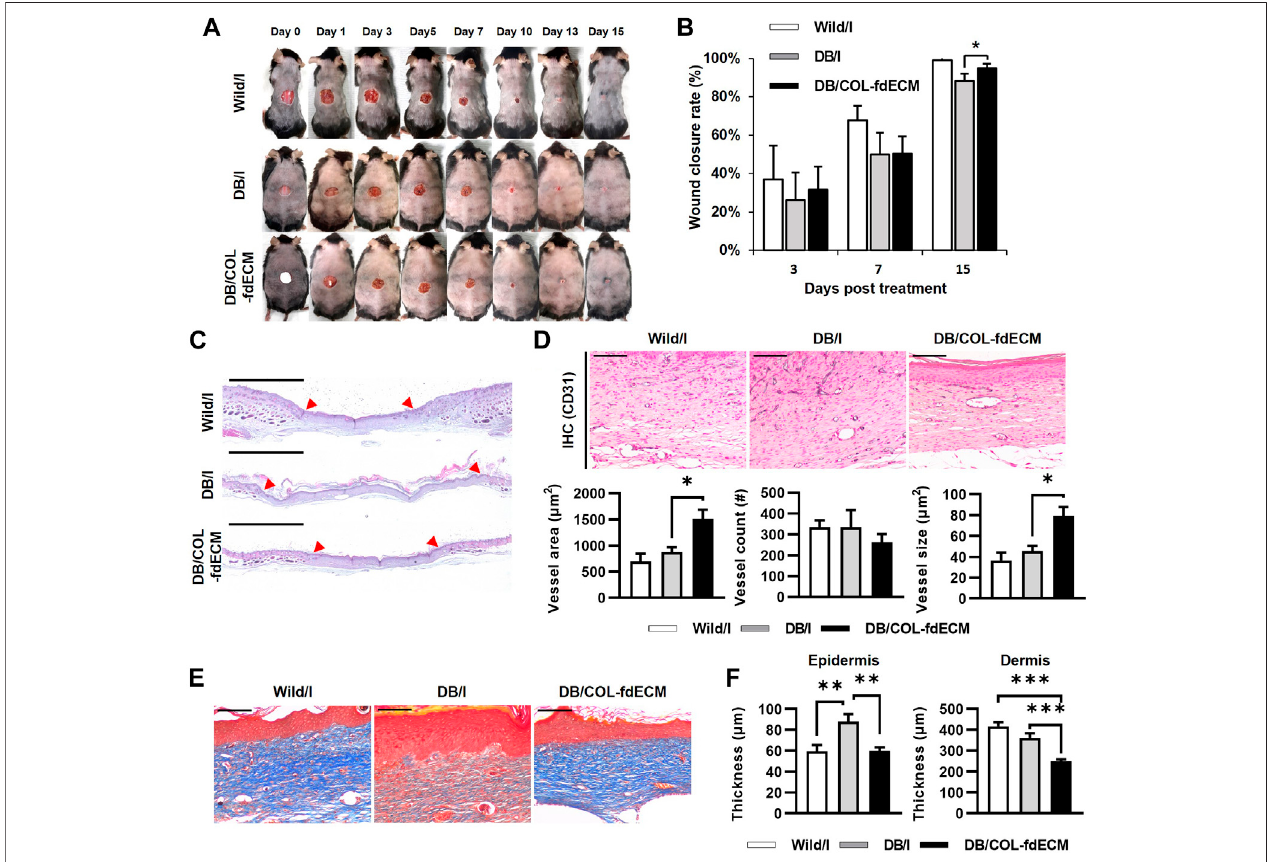
FIGURE 9 | In vivo evaluation of fdECM scaffolds on regeneration of diabetic skin wound model. (A) Gross evaluation of skin wounds after 15 days of fdECM treatment, (B) Wound closure rate (%) measured on day 3, 7, and 15, (C) Whole-mount images of fdECM treated skin wound stained with hematoxylin and eosin. Red arrows indicate the originaldefect site. Scale bar represents 2 mm, (D) Immunohistochemistry images stained with anti-CD31antibody after 15 days oftreatment (Gray color indicates a positive reaction), Scale bar represents 100 μ m, Vessel area, and count were calculated per dermis area (mm 2 ), (E) Histological images of upper dermis stained with Masson ’ s trichrome. Scale bars represent 100 μ m. (F) Epidermal and dermal thickness in wound area. Bar represents mean ± standard error of mean (SEM). * p < 0.05, ** p < 0.01, *** p <